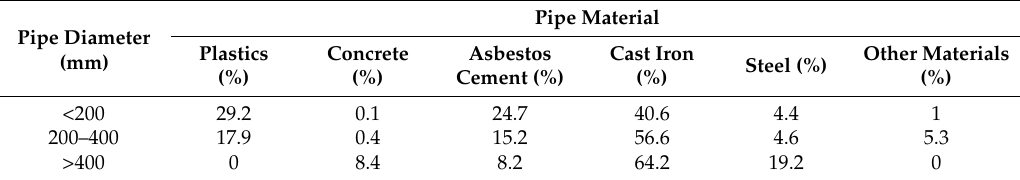
Table 1. Share of water distribution pipelines depending on the pipe diameter and material type